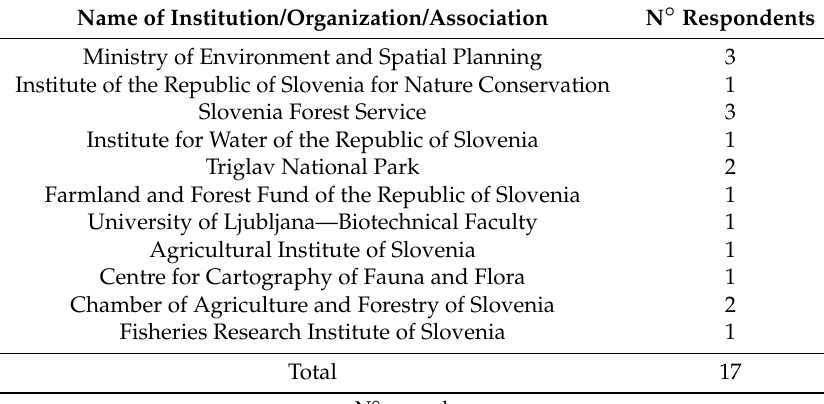
Table 2. Stakeholders Involved in the